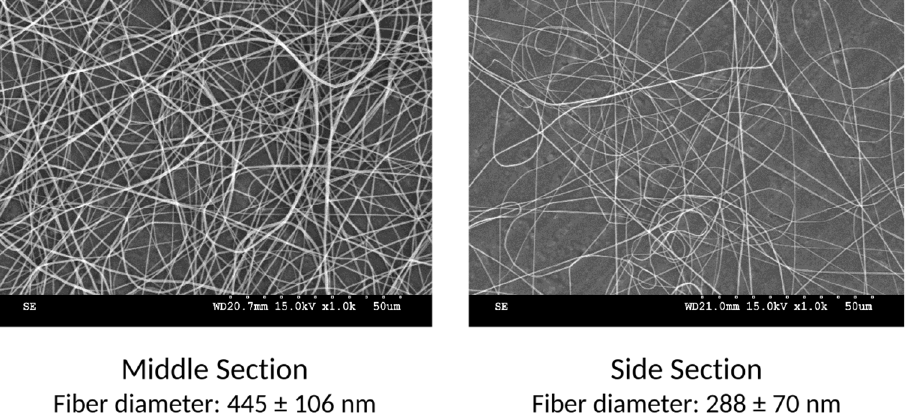
Figure 3. Example of the fibers from the middle and the side sections with initial setup (without auxiliary electrodes).